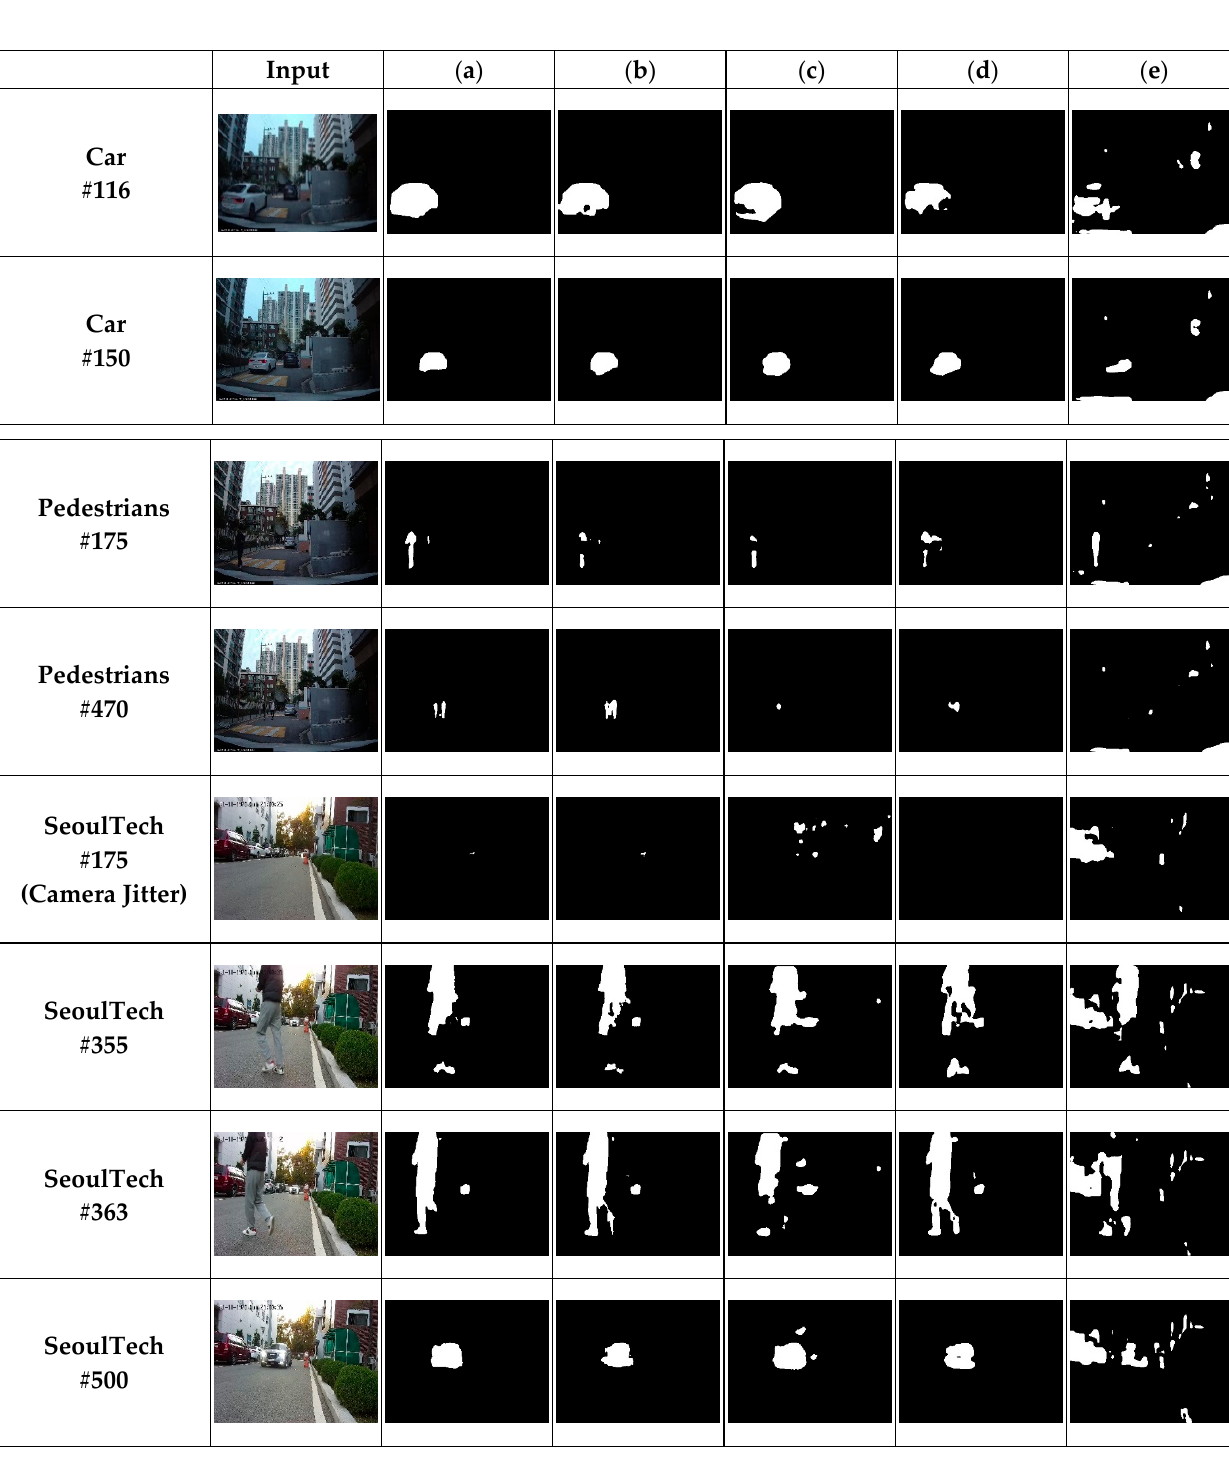
Figure 7. Qualitative results on real scenes that were not used in training: ( a ) proposed method trained using 49 scenes in the CDnet 2014 dataset, ( b ) proposed method trained using 24 scenes in the CDnet 2014 dataset, ( c ) SuBSENSE [2], ( d ) modified FgSegNet-v2, ( e ) FgSegNet-v2 [42].